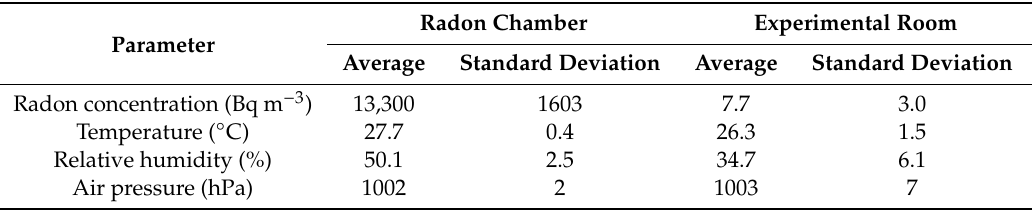
Table 1. Radon concentration and environmental parameters in the radon chamber and an experimental